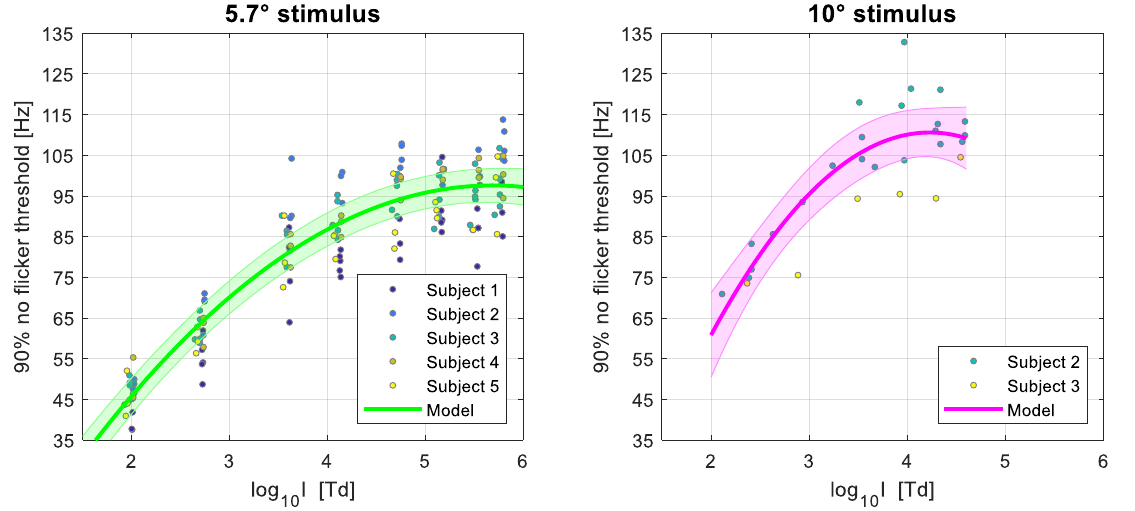
Figure 6. Quadratic linear mixed model results of the 90% “no flicker” threshold as a function of log 10 retinal illuminance, for stimulus sizes of 5.7 ( left ) and 10 ( right ) degrees of visual angle. The continuous colored lines represent the model fit and the shaded regions represent the 95% confi- dence intervals. The individual markers show the estimated thresholds for each subject over several experimental sessions, and the color of the markers represents the participant as indicated by the legend. Table 3. Linear mixed model results of the 90% “no flicker” threshold as a function of log10 retinal illuminance and squared log10 retinal illuminance. The parameters estimate (Est.), their standard errors (SE) and 95% confidence intervals (95% CI) are shown, as well as the t-test results and the standard deviation of the different random effects included (RE SD).